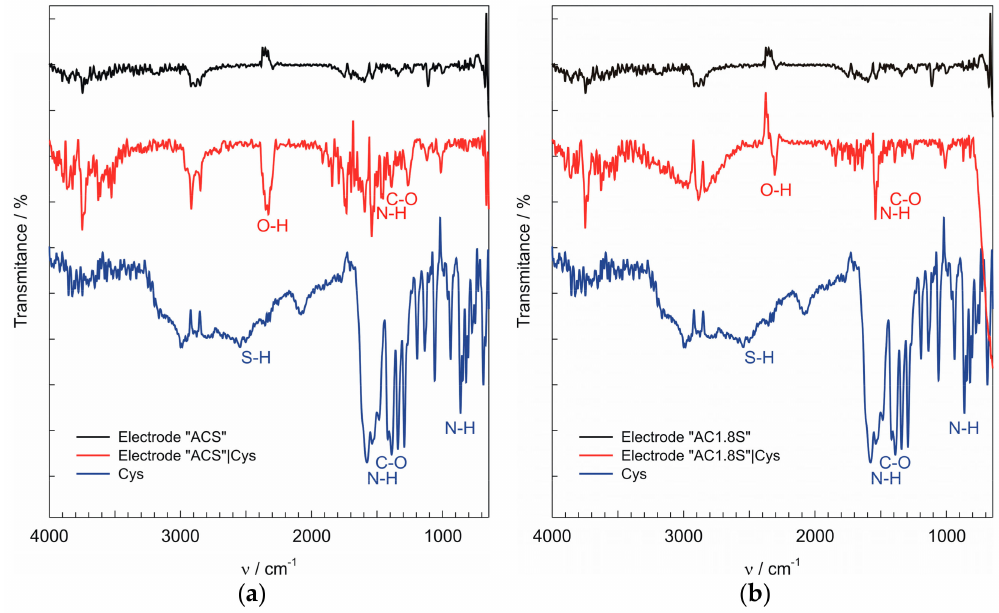
Figure 5. The IR spectra of the: ( a ) electrode “ACS”; ( b ) electrode “AC1.8S”. The surface of the electrodes (black line); Surface of the electrode after CVs was performed (red line); Cysteine powder (blue line).